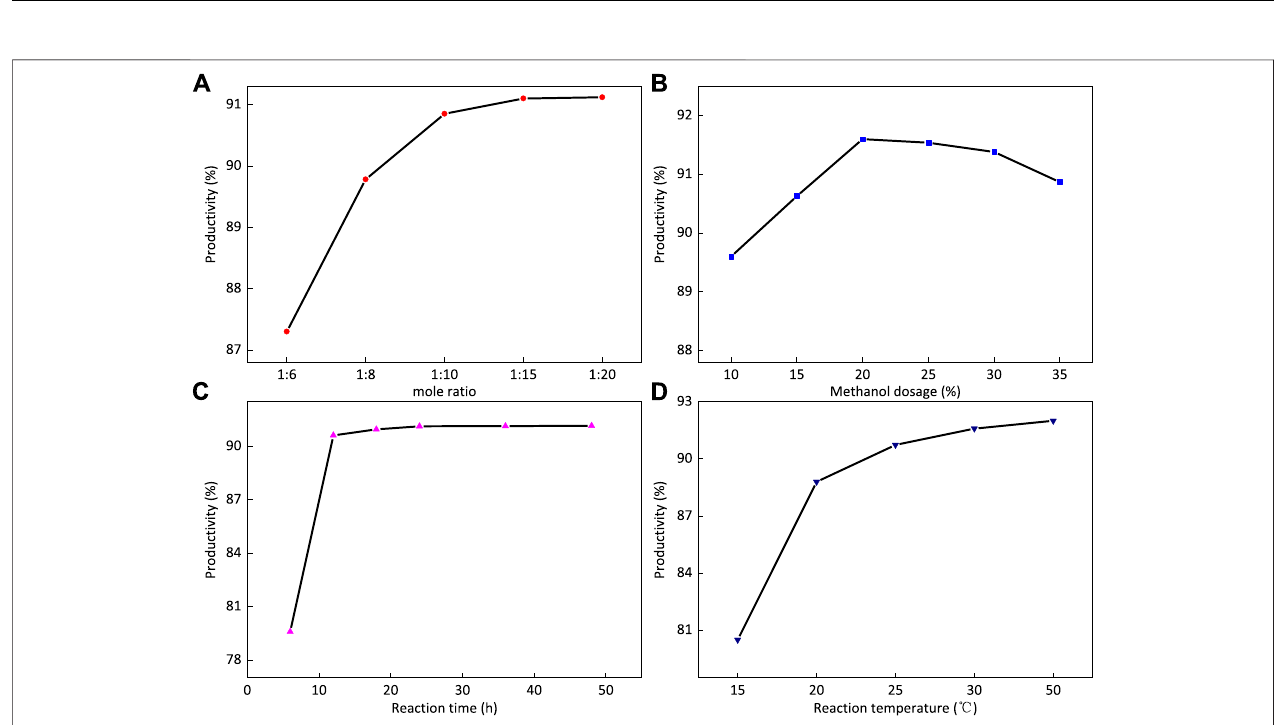
Frontiers in Chemistry |